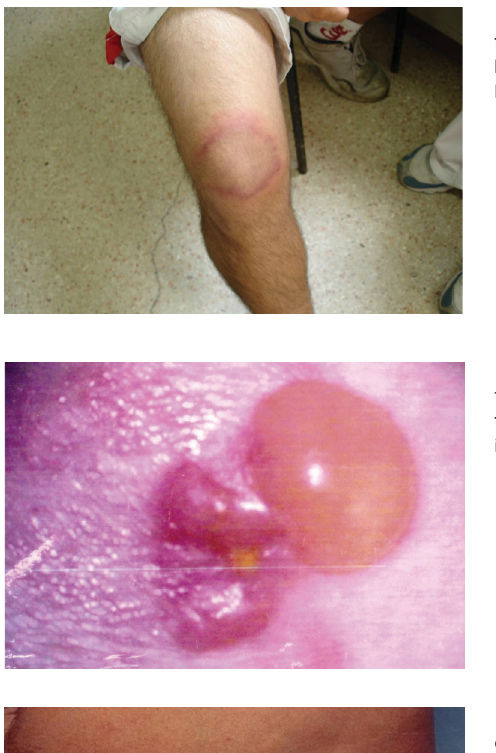
Figure 7. Patient with sclero- derma-like lesion at the tick bite site.